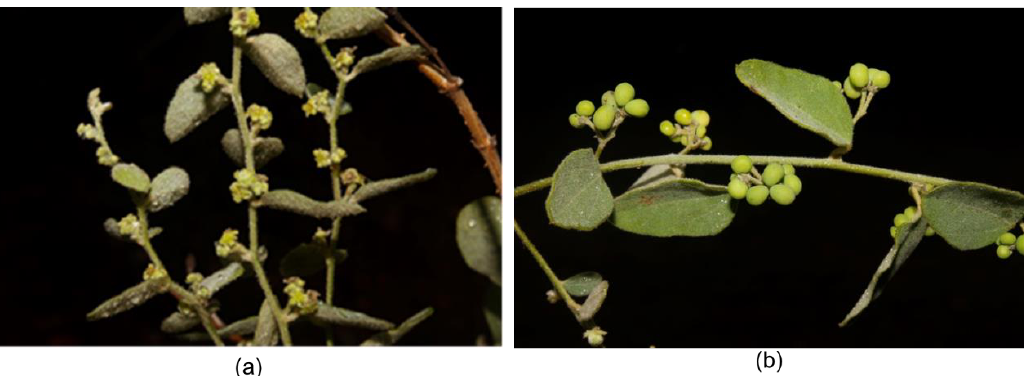
Figure 1. Photographs of male ( a ) and female ( b ) plants of Cocculus hirsutus (Photos by Dr. D. Narasimhan and Mr. K. Devanathan).